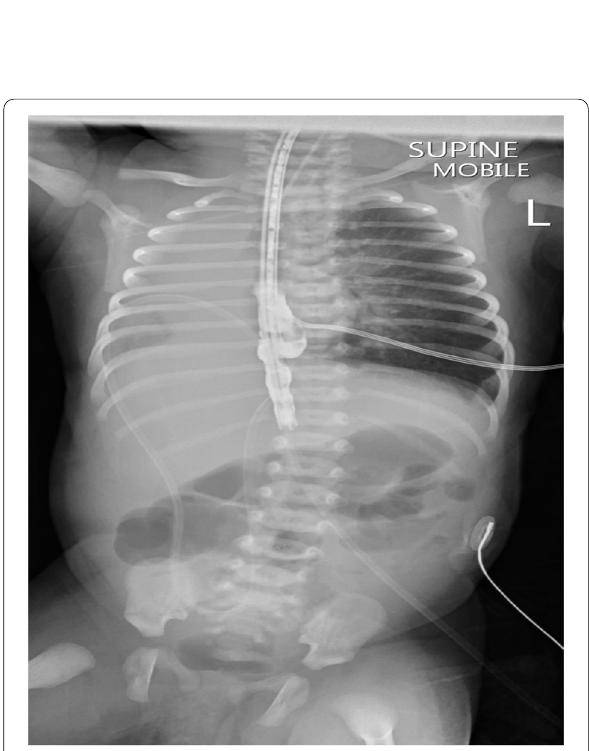
Fig. 2 Upper gastrointestinal water-soluble contrast, with Replogle tube in situ, shows a blind ending oesophagus below the